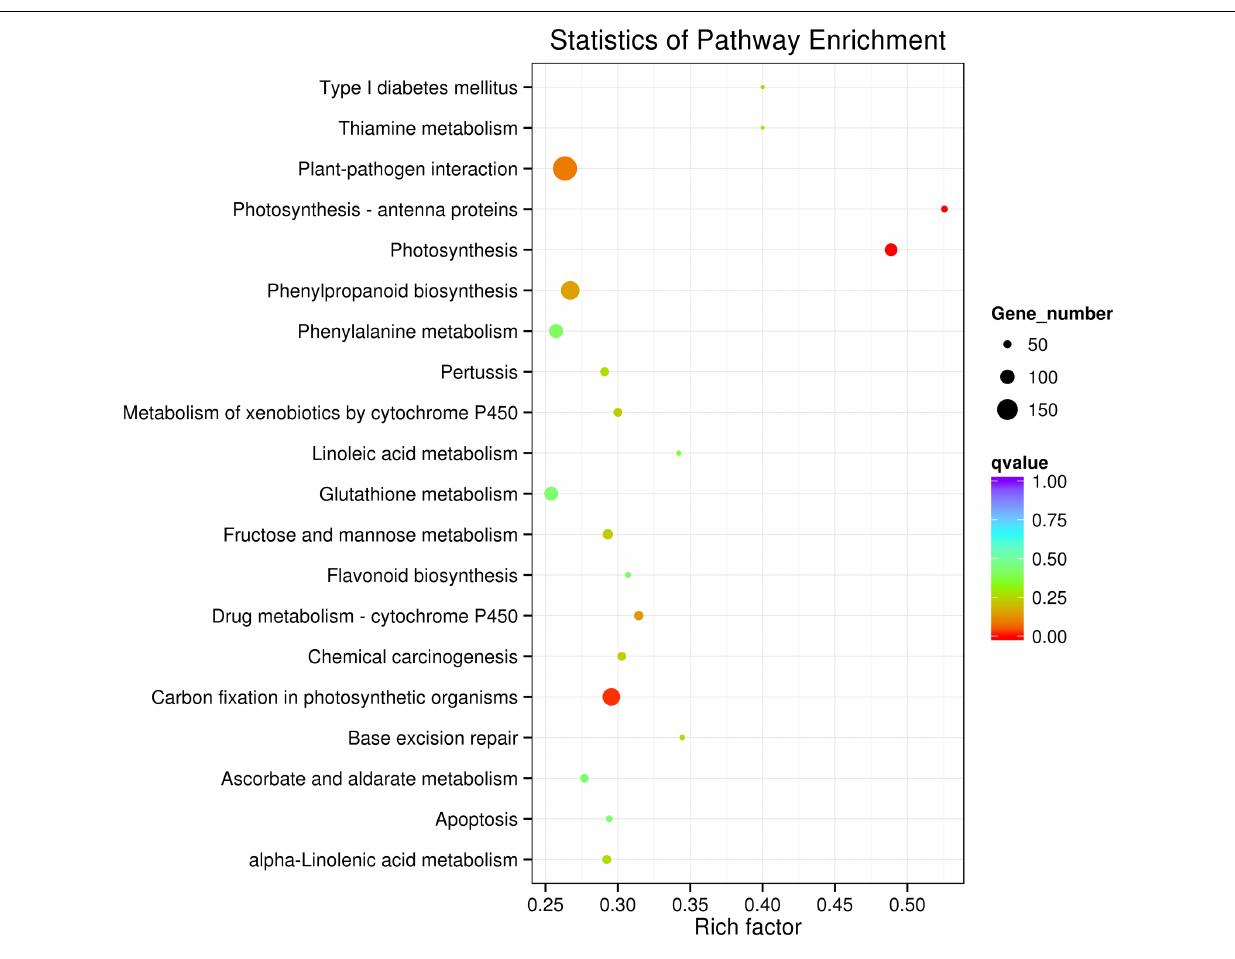
HSP genes, 18 genes were various types of small HSP (sHSP) (cytosolic classes I, II, and III, chloroplast, mitochondrial and endoplasmic reticulum), 6 coded for HSP60, 16 for